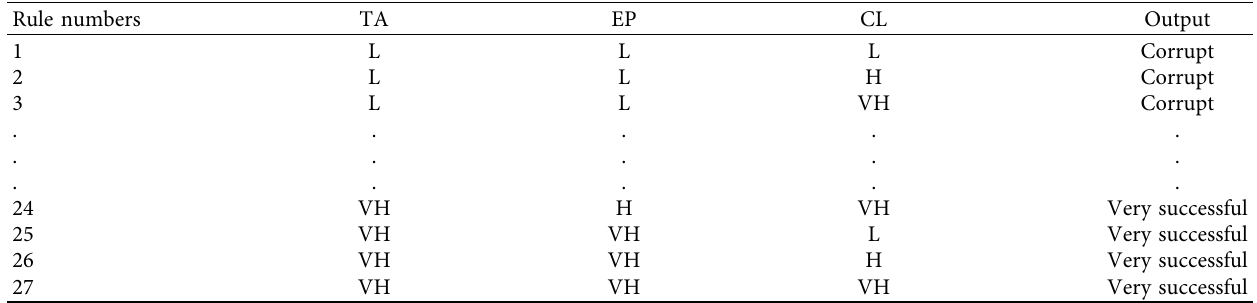
Table 3: Extracted rules.